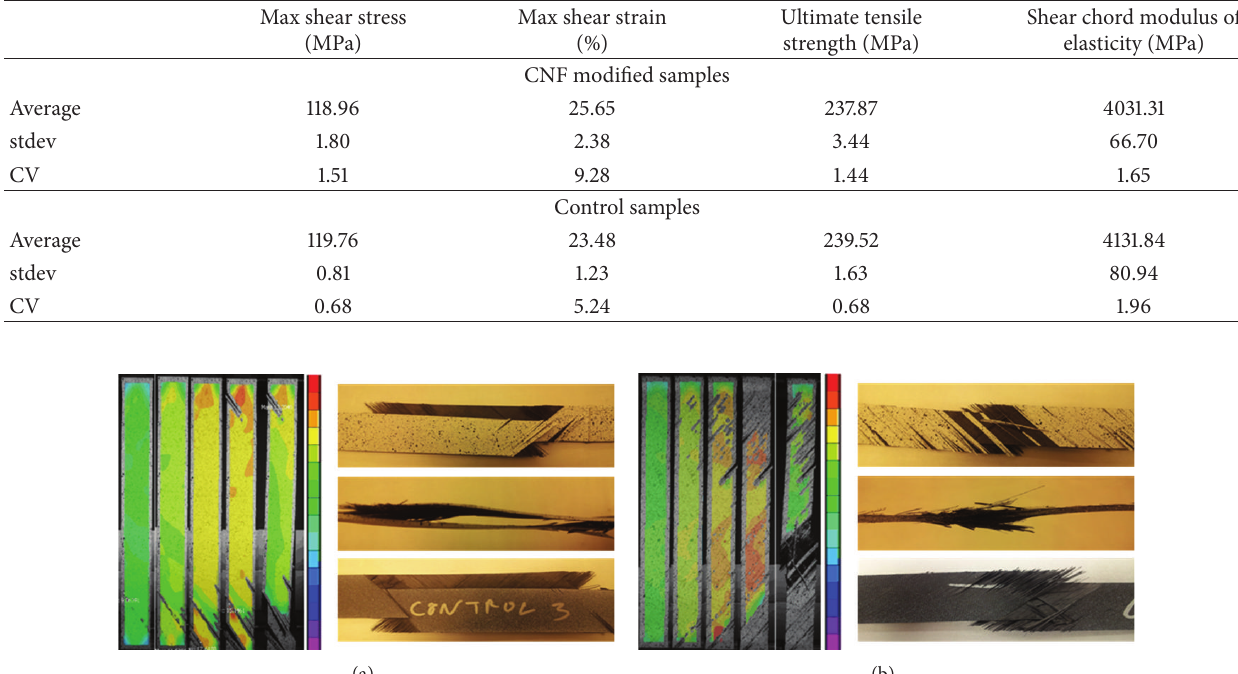
Table 1: Average interlaminar shear response with standard deviations and coefficients of variation.